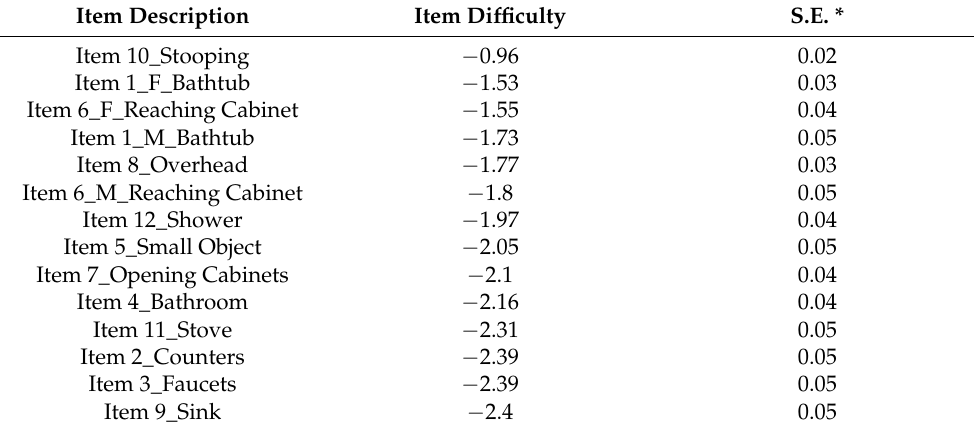
Table 3. Item Difficulties of 14 American Housing Survey Physical Function at Home